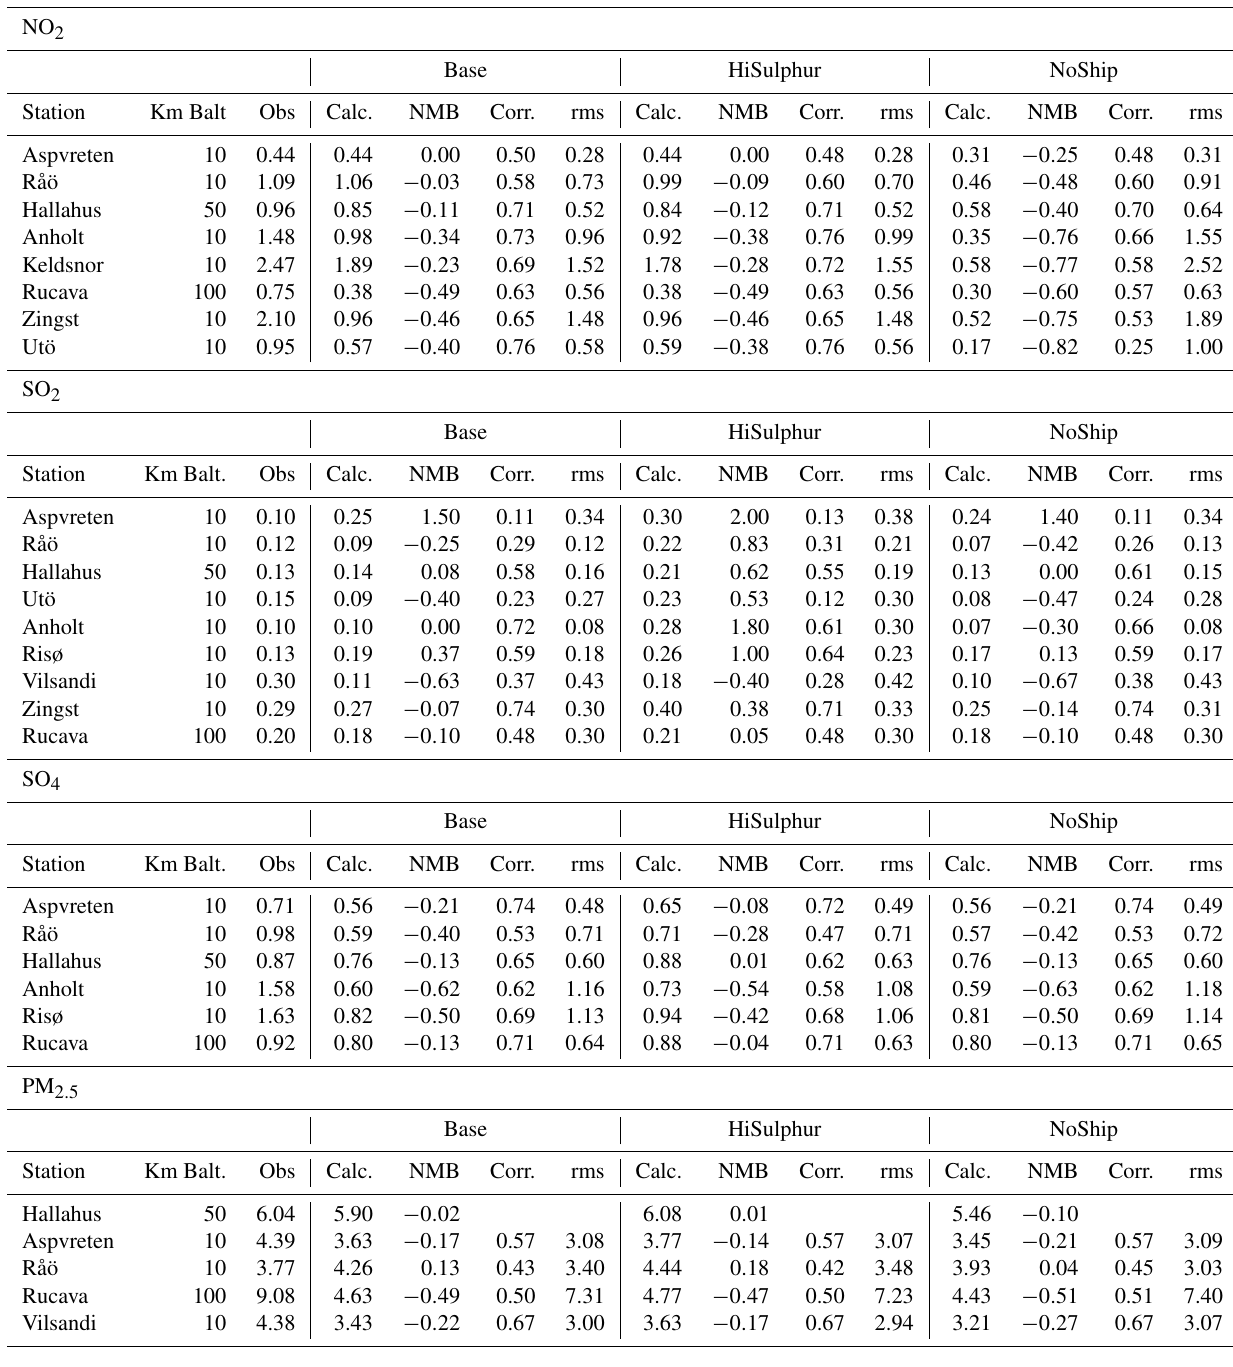
Table 2. Annual average measured (Obs) and model-calculated concentrations (Calc) of NO 2 and SO 2 for the present (2016) Base, NoShip, and HiSulphur scenarios. The figure continues on the next page with SO 4 and PM 2 . 5 . Also listed are normalised mean bias (NMB), the daily correlations (Corr.), and rms errors (rms) between model and measurements. For Hallahus there are PM 2 . 5 measurements only for parts of the year, and bias, correlations, and rms errors are not listed. The time-series plots for the same sites are shown in Appendix A. Km Balt. is a classification of the distance in kilometres between the stations and the Baltic Sea coast. The distance is equal to or smaller than the distance listed. The positions of the measurement sites and the time-series plots are shown in Appendix